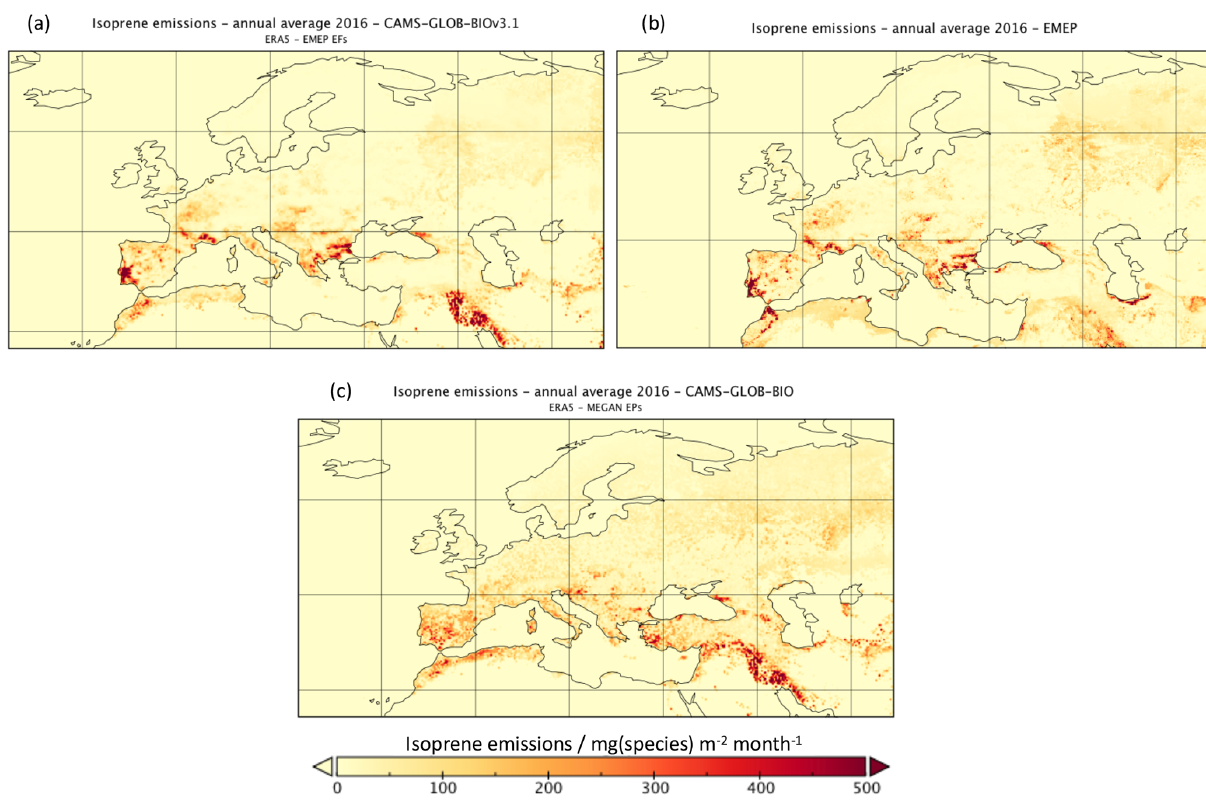
Figure 5. Comparison of European annual mean isoprene emissions in 2016 from (a) the EMEP model and (b) CAMS-GLOB-BIOv3.1. Panel (c) shows annual mean isoprene emissions calculated with default MEGAN EP maps.